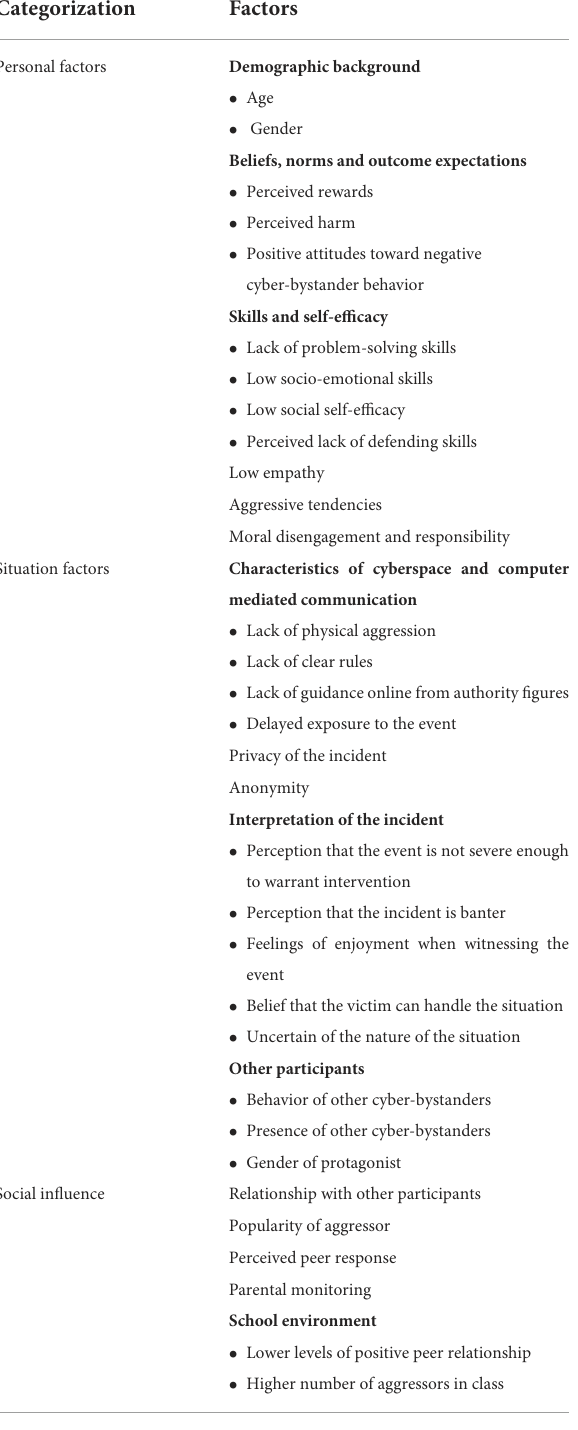
TABLE 3 Factors influencing negative cyber-bystander behavior identified in the current